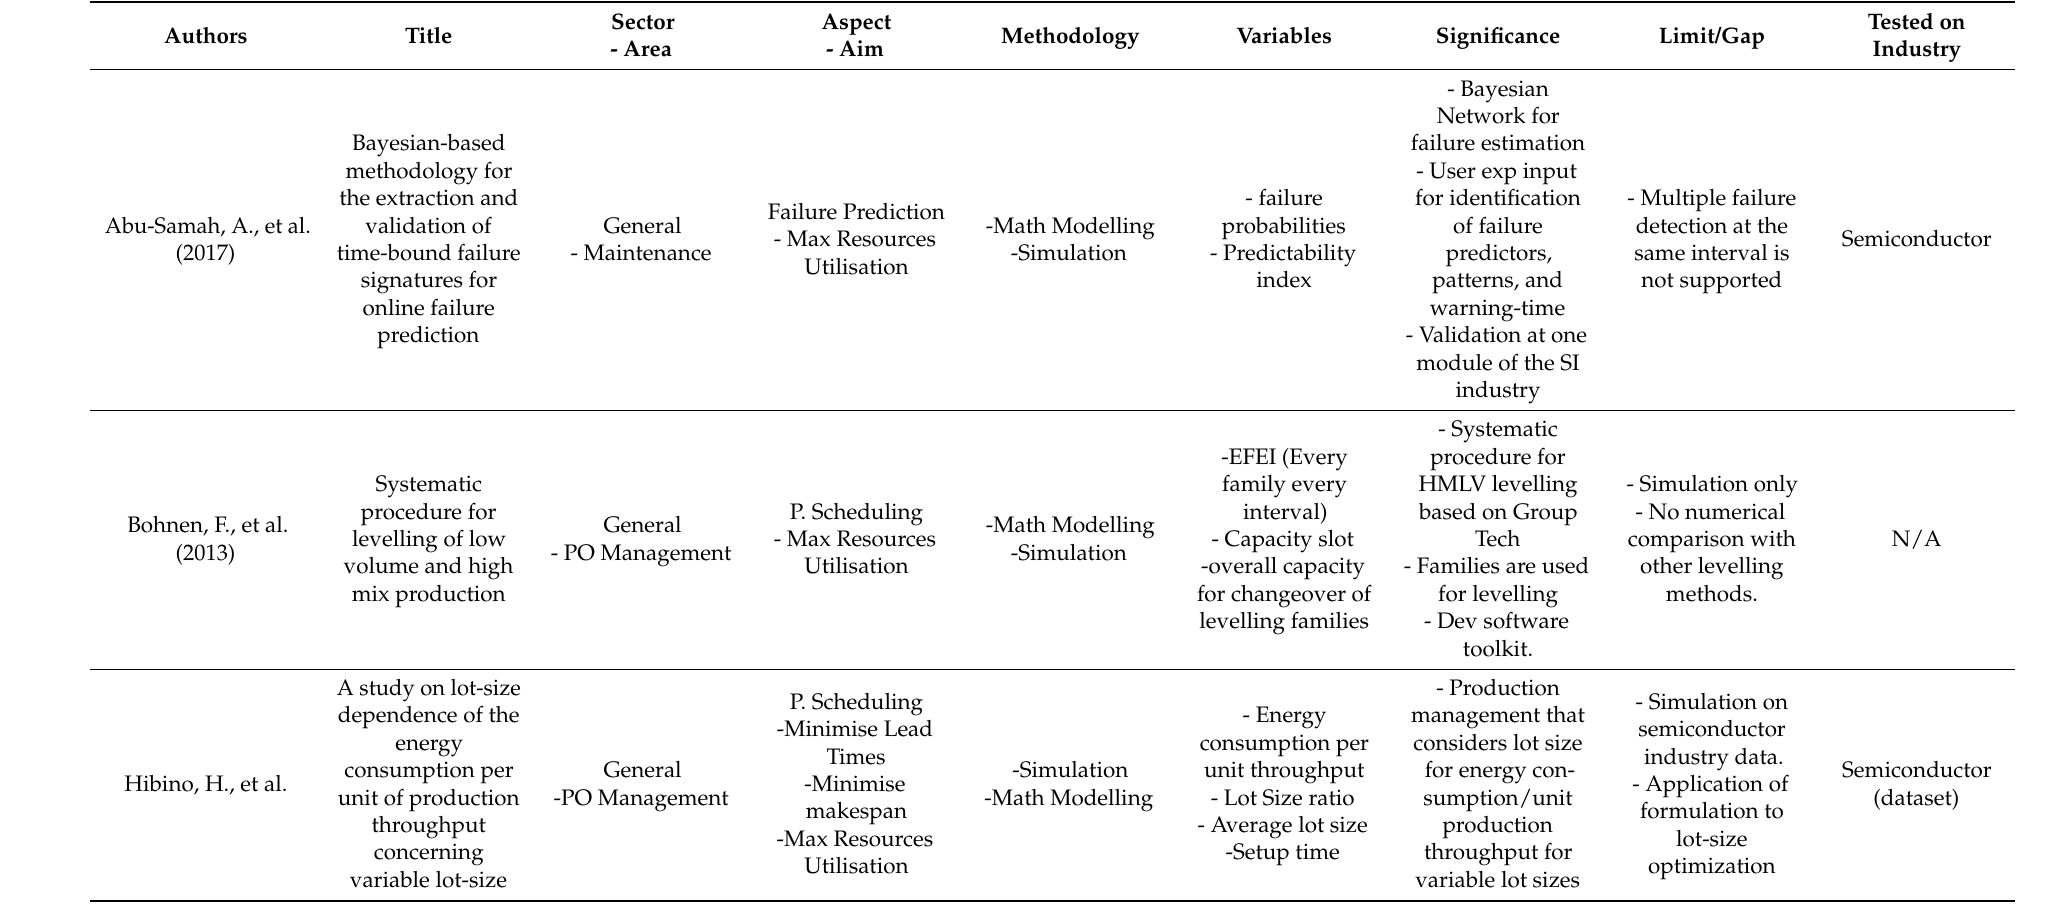
Table 3. Excerpt of the data extraction of each document in step